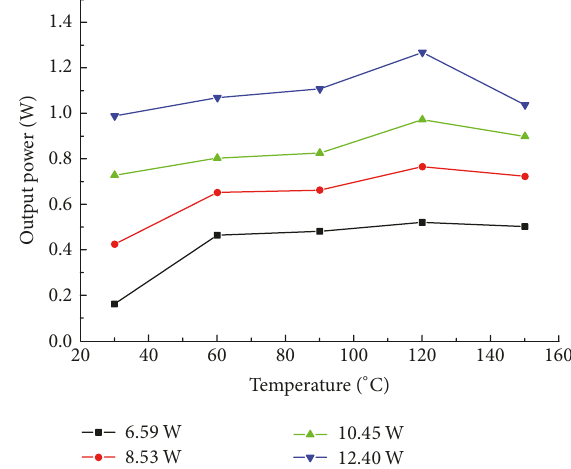
Figure 4: The idler output power with temperature tuning under different incident pump